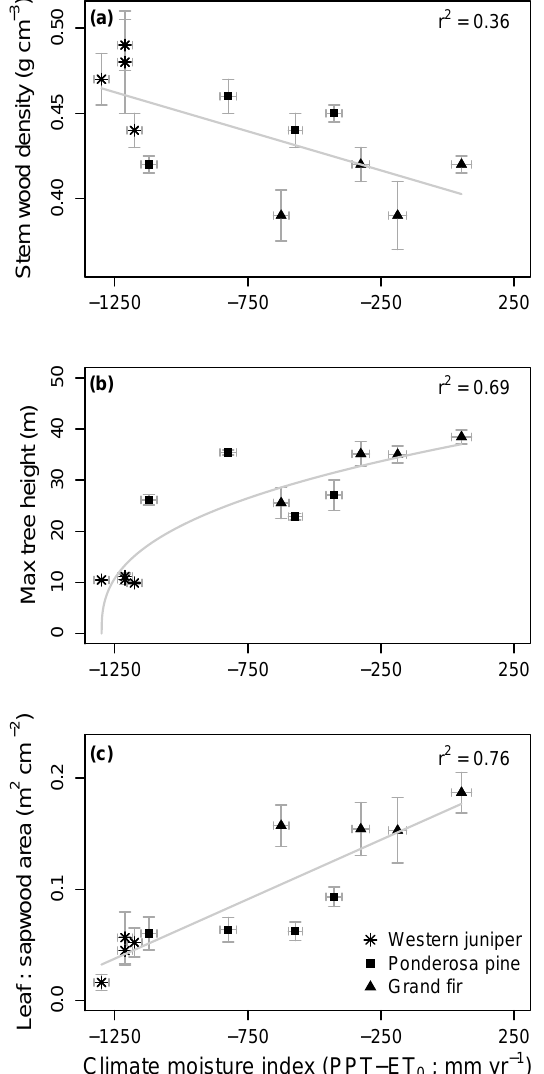
Figure 6. Forest ecosystem (a) average stem wood density, (b) max- imum tree height, and (c) leaf: sapwood area ratio plotted against the average growing-year climate moisture index from 1964 to 2013 (CMI gy ) . Each point represents the mean ( ± 1SE) of four subplots sampled at each site. Regression coefficients are given in Table